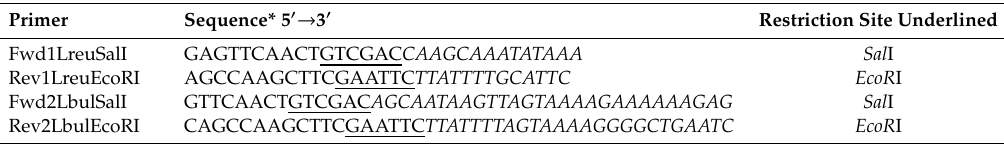
Table 5. Primers used in the